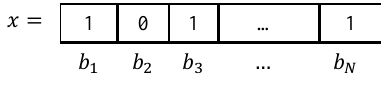
𝑠𝑠 𝑁𝑁 Figure 1. Particle